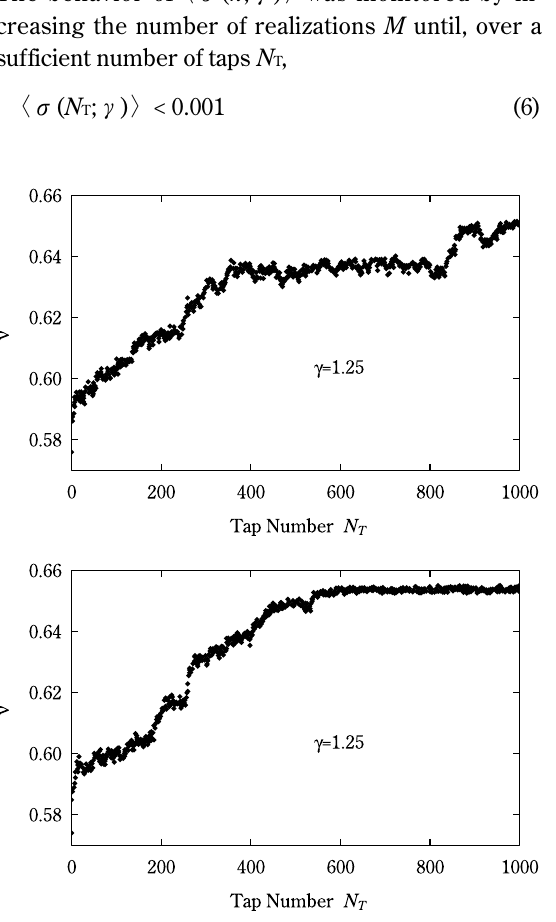
Fig. 2 Bulk solids fraction ν versus tap number N T for two independent realizations at tap intensity γ＝ 1.25. These plots show the typical evolution of the